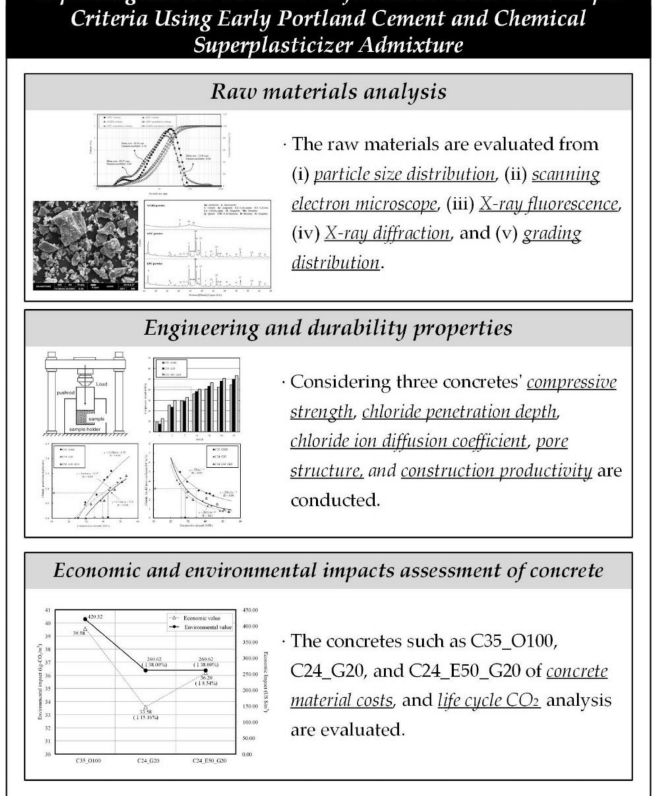
Figure 2. Research